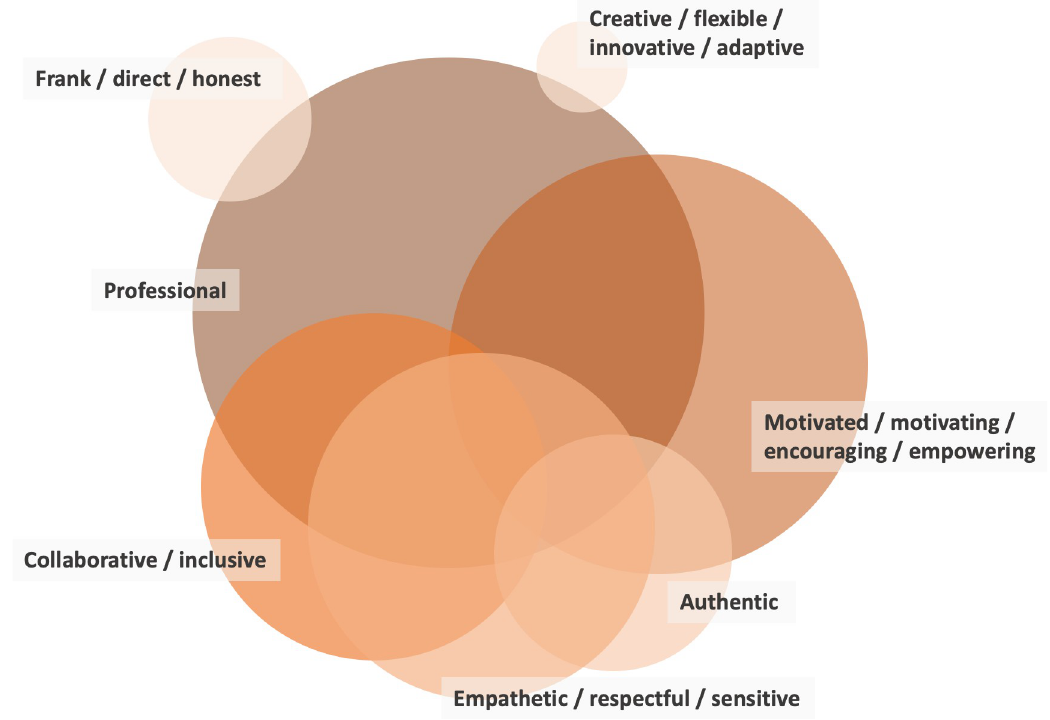
Fig 4. The seven most present attitudes of ISPs in the included articles. The size of the circles indicates the number of studies which reported the specific attitude: professional attitude (n = 28), motivated / motivating / encouraging / empowering attitude (n = 25), empathetic / respectful / sensitive attitude (n = 20), collaborative / inclusive attitude (n = 19), authentic attitude (n = 13), creative / flexible / innovative / adaptive attitude (n = 9), frank / direct / honest attitude (n = 5). Publications were included in this visualization when they reported on at least one type of attitudes. The overlap between circles shows the co-presences of attitudes as reported in the articles.